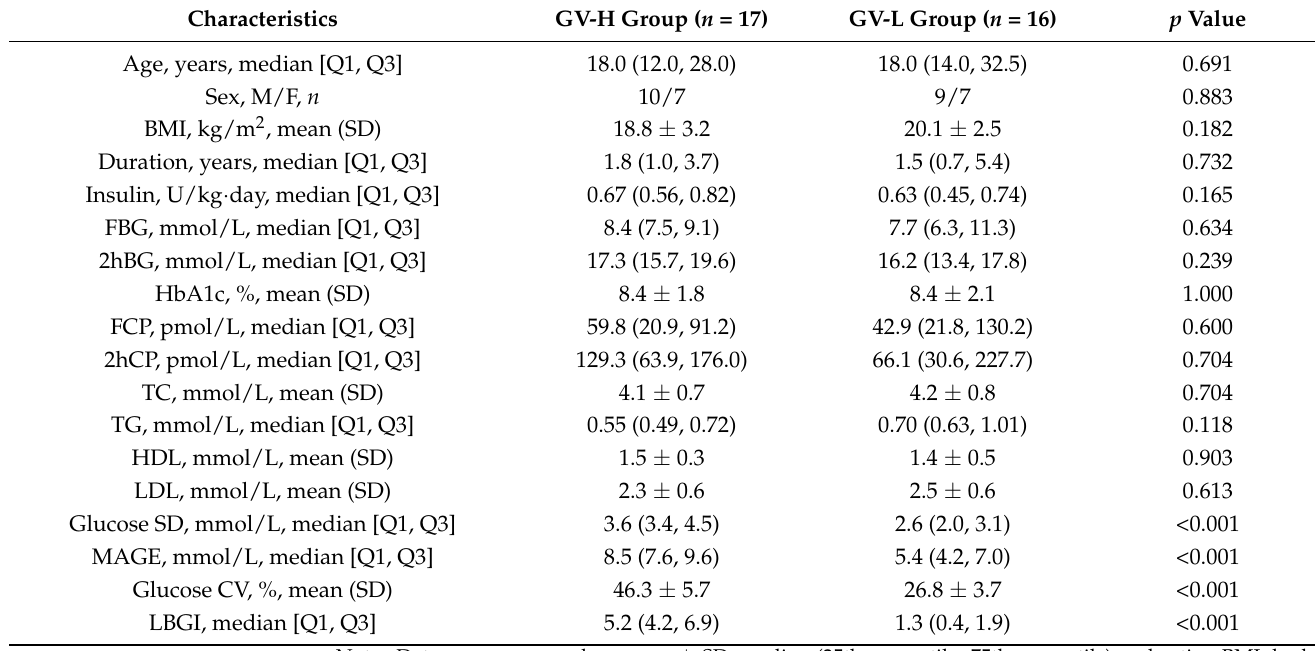
Table 1. Basic characteristics and CGM parameters in GV-H and GV-L groups of the exploratory set.